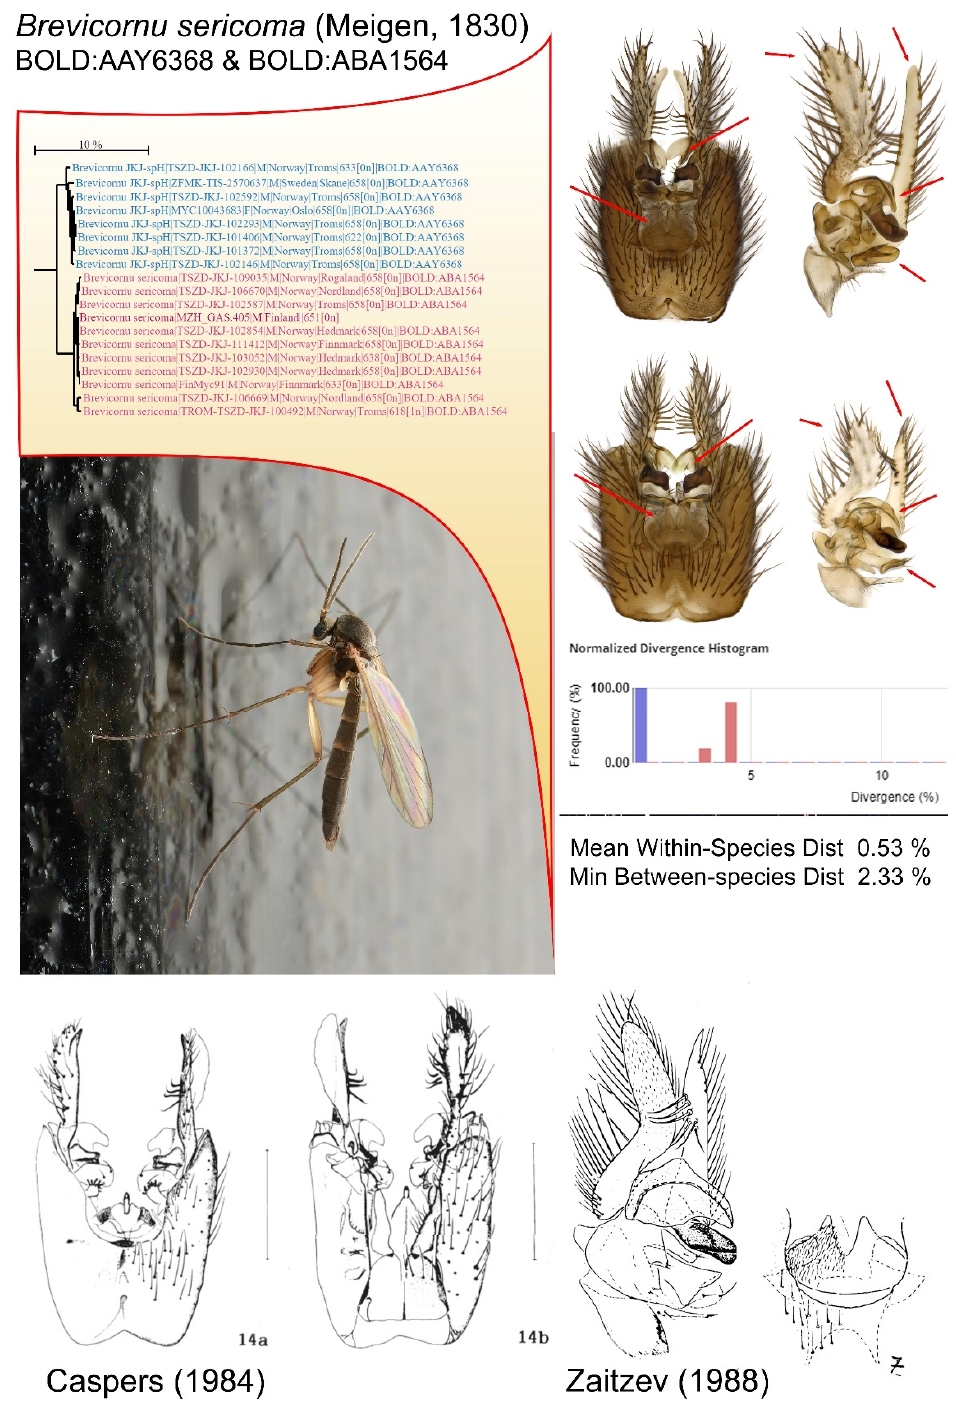
Figure 7. Example of BIN splitting of the Mycetophilid species Brevicornu sericoma (Meigen, 1830). What was previously regarded as one morphological species is split into two distinct BINs, although with a rather small between-species distance of 2.33% and a quite large mean within-species distance of 0.53%. Minor morphological differentiation is found between the BINs but also variation in some characters that do not follow the BIN segregation. Depicted at the bottom are illustrations published by Caspers [80] conforming to BIN BOLD:AAY6368 and Zaitzev [81] conforming to BIN BOLD:ABA1564.